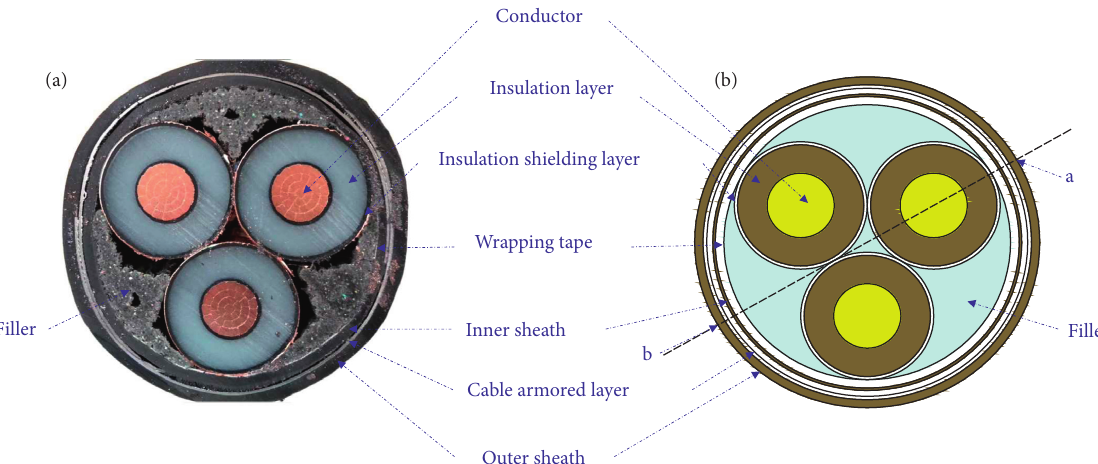
Figure 2: (a) Picture of cable radial section; (b) schematic diagram of cable radial